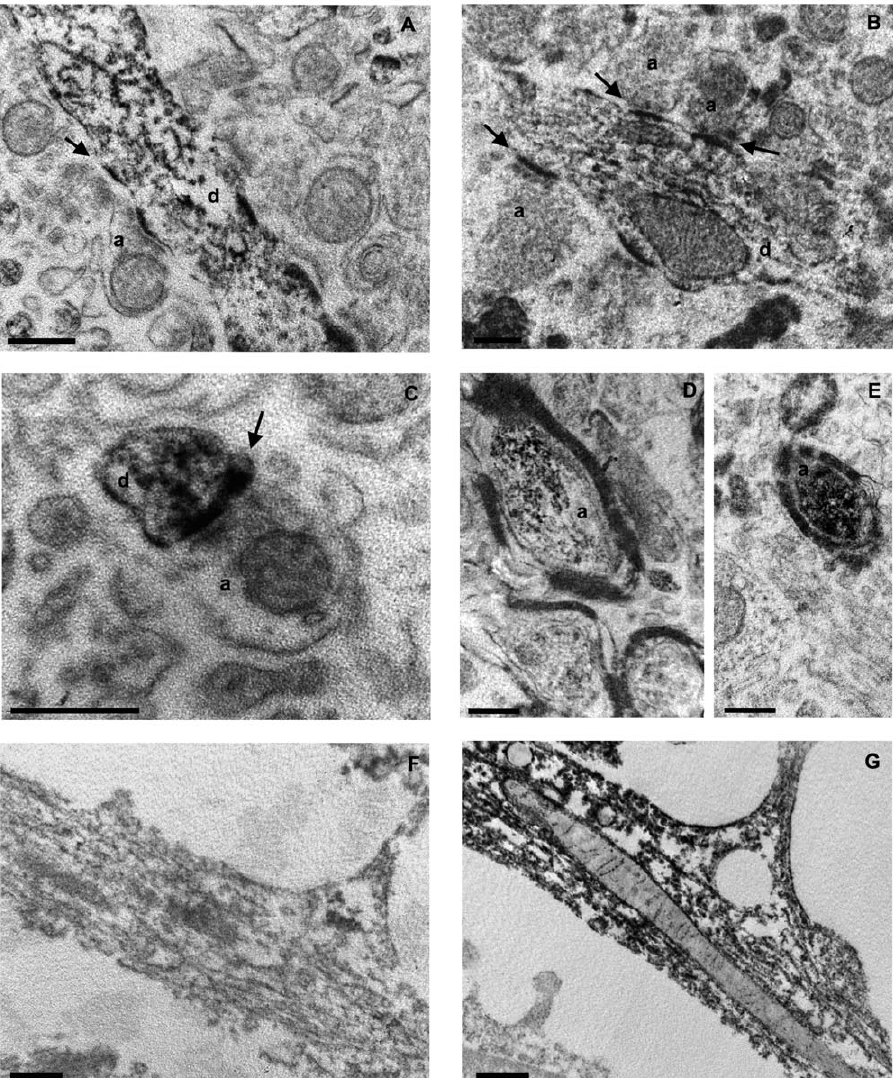
Figure 6. IhNSC-Ps form synapses into the rat hippocampus. Representative electron micrographs of rat hippocampus (A–E) and IhNSC-Ps differentiated in vitro (F–G), immunostained for GFP. (A–C) GFP immunopositive dendrites (d) on which unstained axons (a) project, making synaptic contacts (arrows). (D, E) GFP immunopositive myelinated axons (a). (F) Sham transfected IhNSC-Ps in culture. (G) GFP expressing IhNSC-Ps in culture. To note, GFP is mainly associated to microtubular structures. Scale bars: 500 nm.